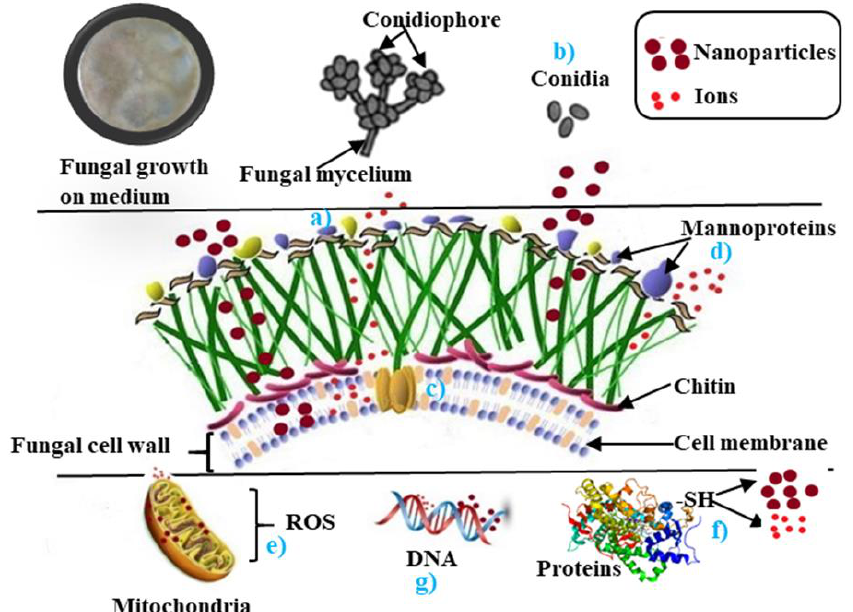
Figure 1. This is an illustration of the possible mechanisms of action of metal nanoparticles on phytopathogenic fungi. These are as follows: ( a ) ions are released by nanoparticles and bind to certain protein groups, which affect the function of essential membrane proteins and interfere with cell permeability. ( b ) The nanoparticles inhibit the germination of the conidia and suppress their development. ( c ) Nanoparticles and released ions disrupt electron transport, protein oxidation, and alter membrane potential. ( d ) They also interfere with protein oxidative electron transport. ( e ) They affect the potential of the mitochondrial membrane by increasing the levels of transcription of genes in response to oxidative stress (ROS). ( f ) ROS induces the generation of reactive oxygen species, triggering oxidation reactions catalyzed by the different metallic nanoparticles, causing severe damage to proteins, membranes, and deoxyribonucleic acid (DNA), and interfering with nutrient absorption. ( g ) The ions of the nanoparticles have a genotoxic effect that destroys DNA, therefore causing cell death [58–62].